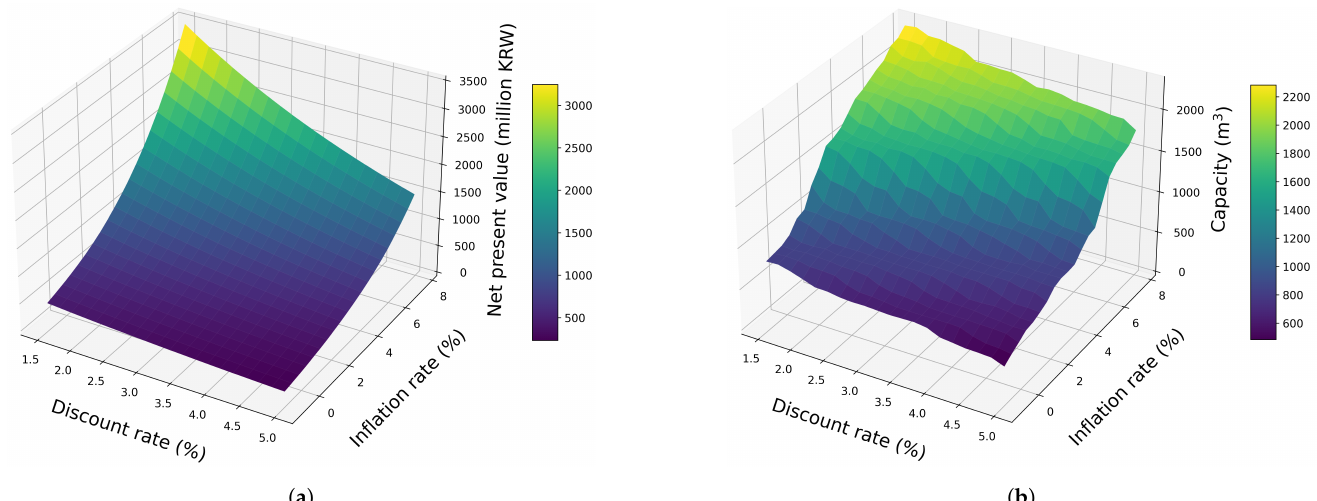
Figure 12. The results of our sensitivity analysis for the inflation and discount rates: ( a ) the maximum net present value; ( b ) the corresponding